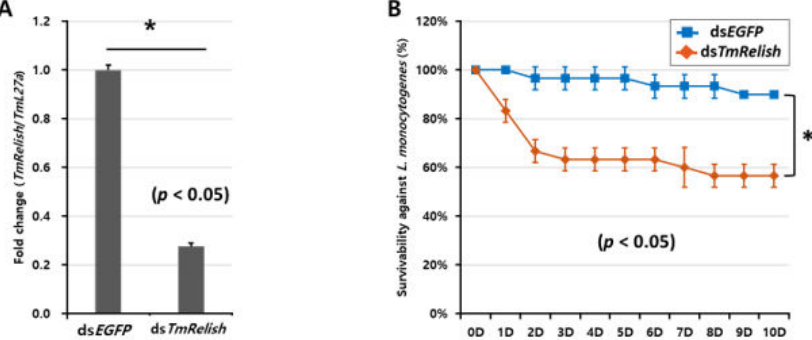
Figure 2. E ff ect of TmRelish silencing on the survival of T. molitor larvae after challenging with L. monocytogenes for10days. Knockdowne ffi ciencyof TmRelish mRNA,extractedfromds TmRelish -injected larvae in comparison ds EGFP injected group was measured 3-day post-injection by qRT-PCR ( A ). Survival results for ds TmRelish -injected larvae after L. monocytogenes challenge are presented as the average of three biological replicates ( B ). The ds EGFP -injected groups followed by same microbial infection were used as negative controls. ‘*’ indicates significant di ff erences between ds TmRelish and ds EGFP -treated groups ( p <